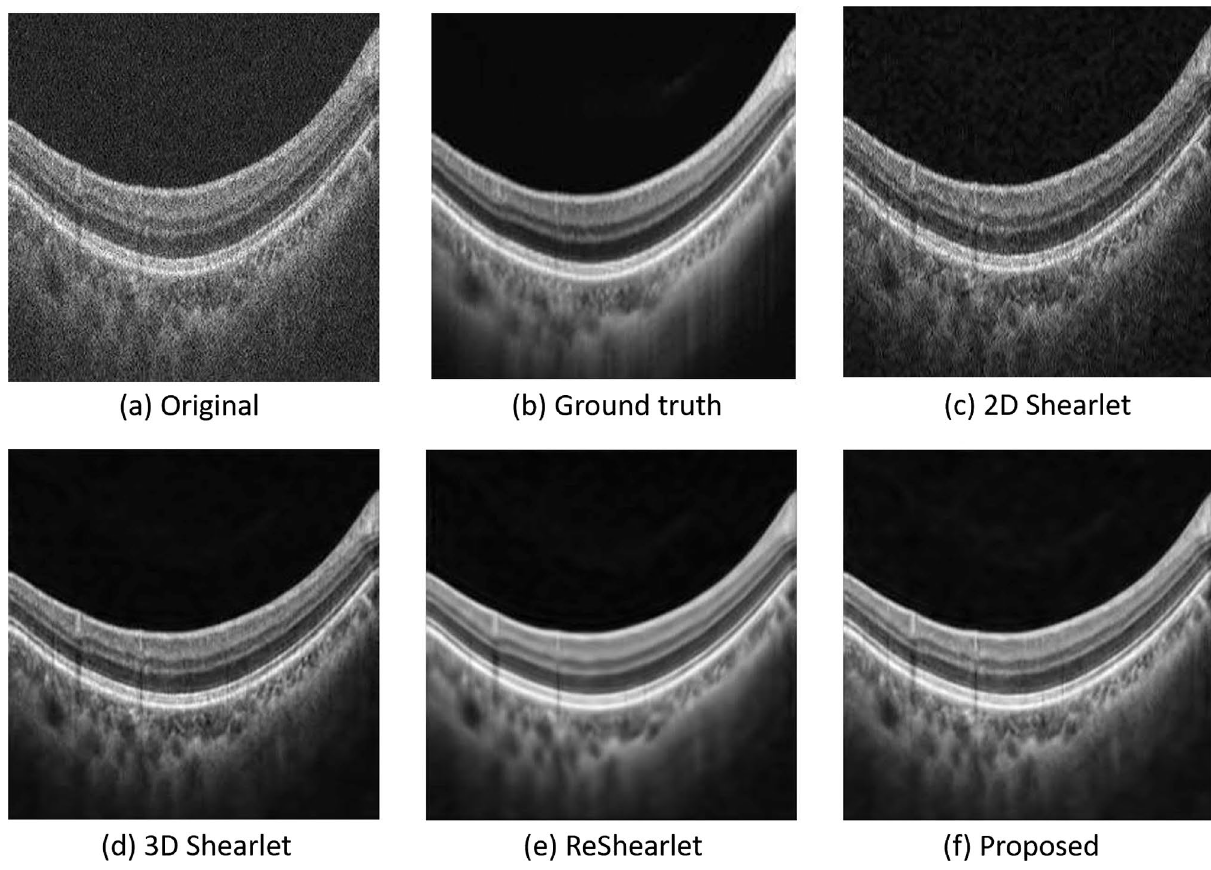
Figure 6. Normal sample images by our adaptive-SIN and other shearlet-related algorithms for the ablation study. ( a ) the original noisy image, ( b ) the ground-truth denoised image captured by multiple repeated scanning, ( c )–( e ) are the results by 2D shearlet, 3D shearlet and ReShearlet, ( f ) the result by the proposed algorithm.